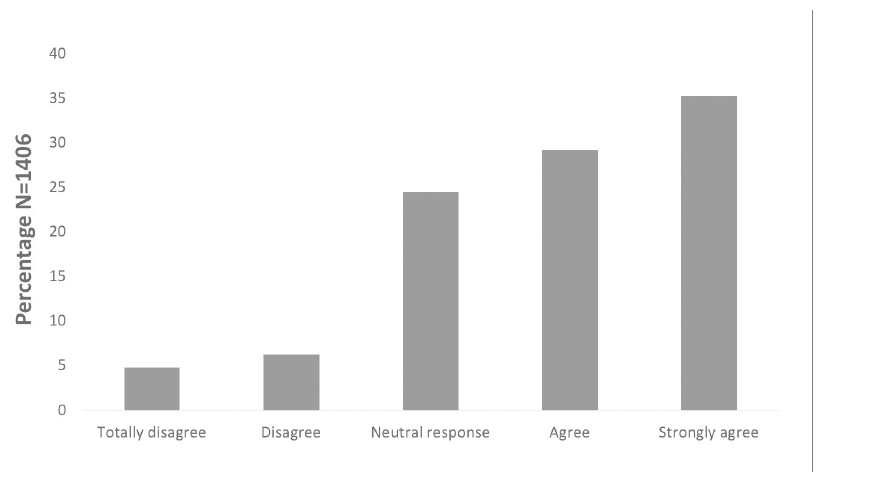
Fig 2. Acceptance towards COVID-19 vaccine (N =